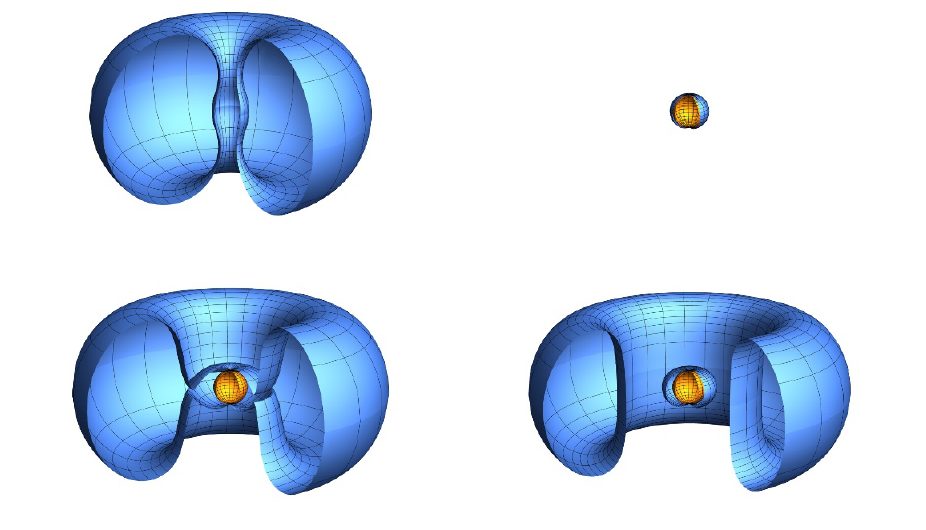
Figure 4 . Illustration of the ergo-surfaces of some selected solutions. (Upper left panel) Spinning soliton along the second (backward) branch with ! = 0 : 8; (upper right panel) hairy BH along the (cid:12)rst (forward) branch with r h = 0 : 01 and ! = 0 : 8; (lower left panel) hairy BH along second (backward) branch with r h = 0 : 01 and ! = 0 : 7; (bottom right panel) hairy BH along the second (backward) branch with r h = 0 : 01 and ! = 0 : 685. In the last three plots the event horizon is plotted as a yellow